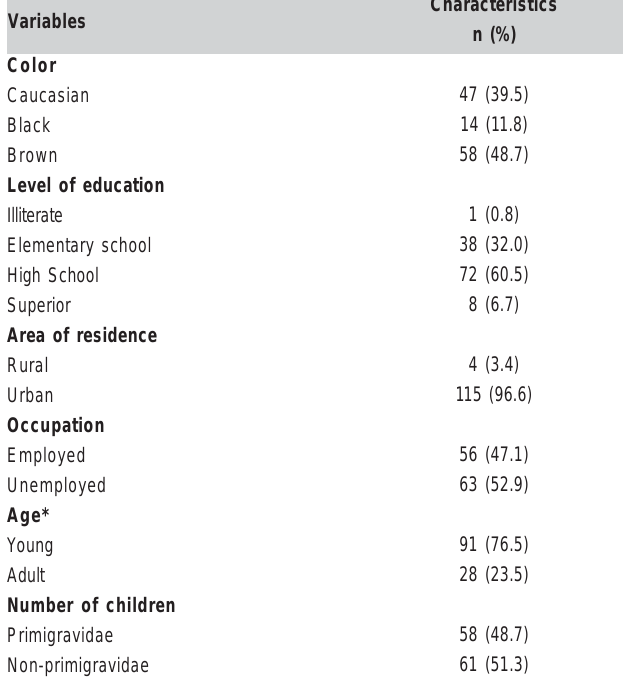
Table 1 – Numeric distribution and percentage of social, economical and demographical